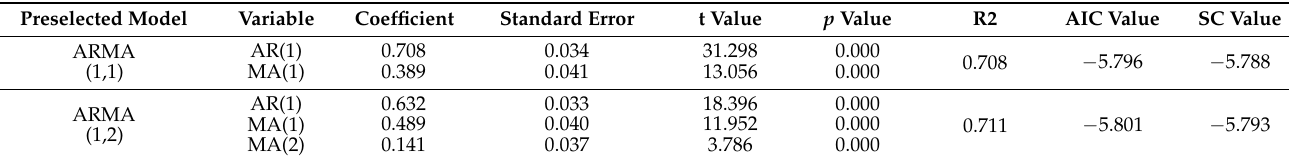
Table 2. Parameter estimation results of ARMA